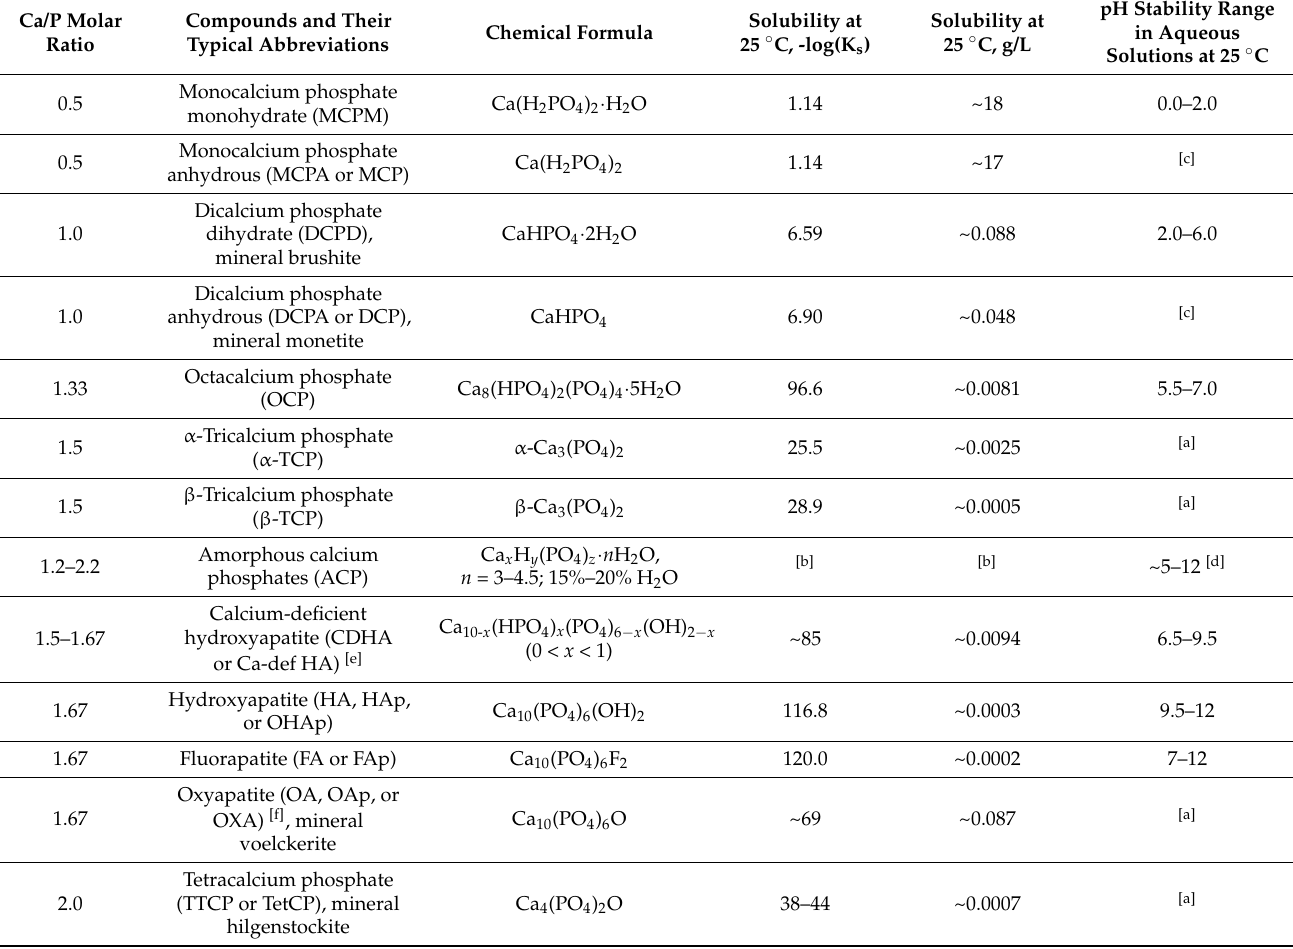
Table 1. Existing calcium orthophosphates and their major properties